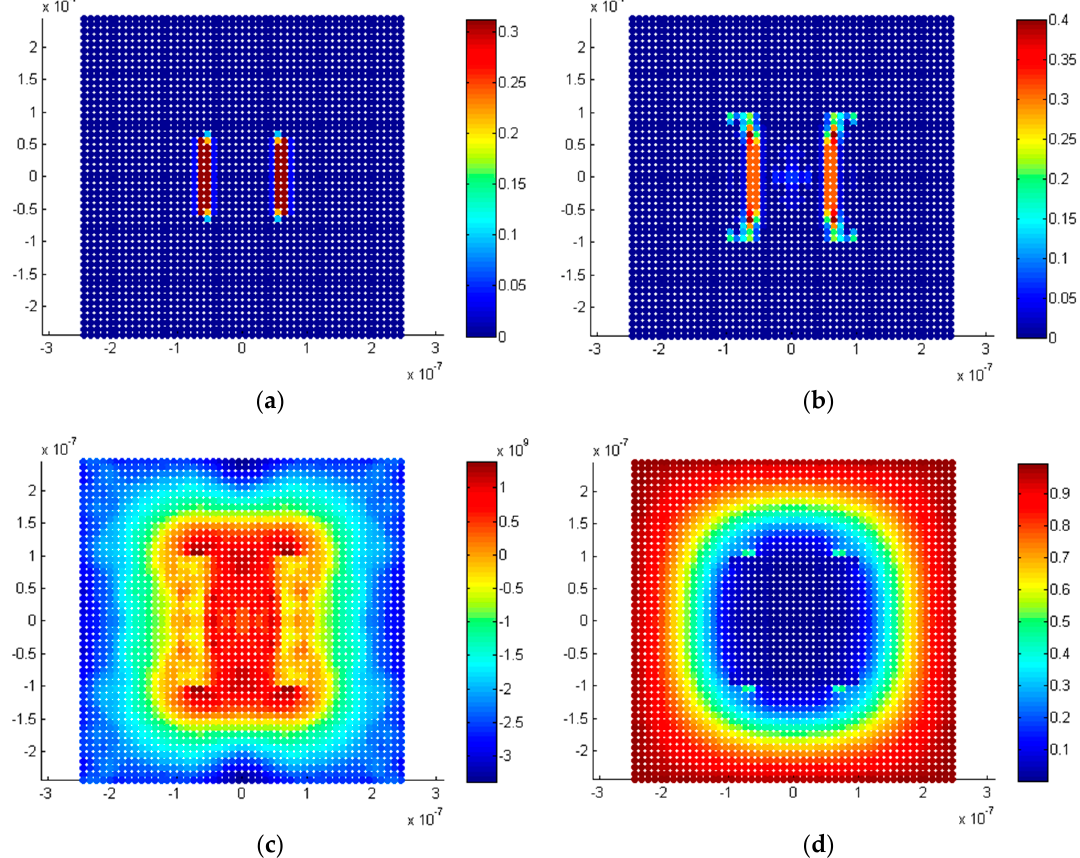
Figure 15. Result plots of twin vertical cracks cylinder in the x - z mid-plane: ( a ) initial damage; ( b ) damage after deformation; ( c ) hydrostatic stress; and ( d ) lithium ion concentration.